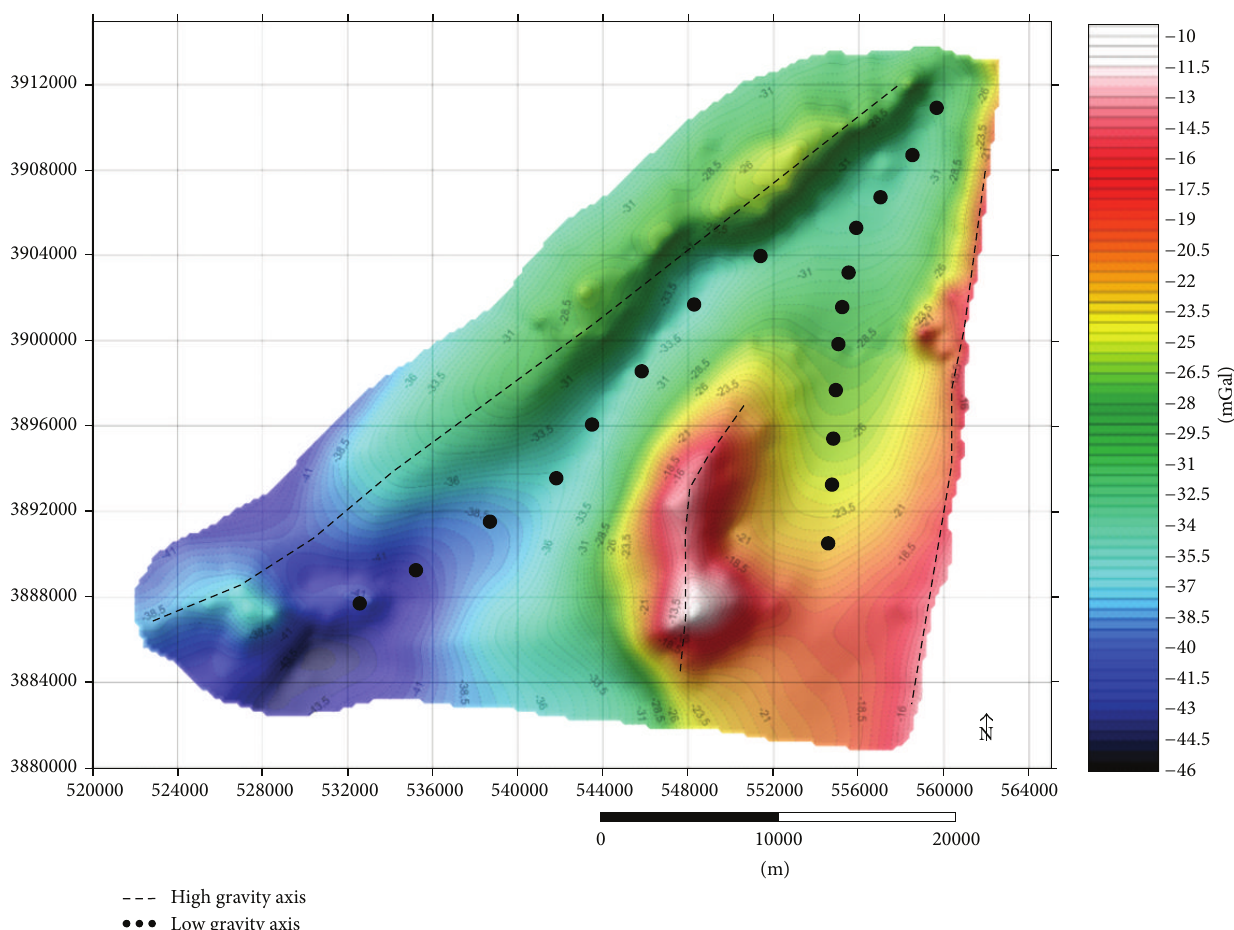
Figure 4: Bouguer gravity map of the study zone showing the positive and the negative trends of the